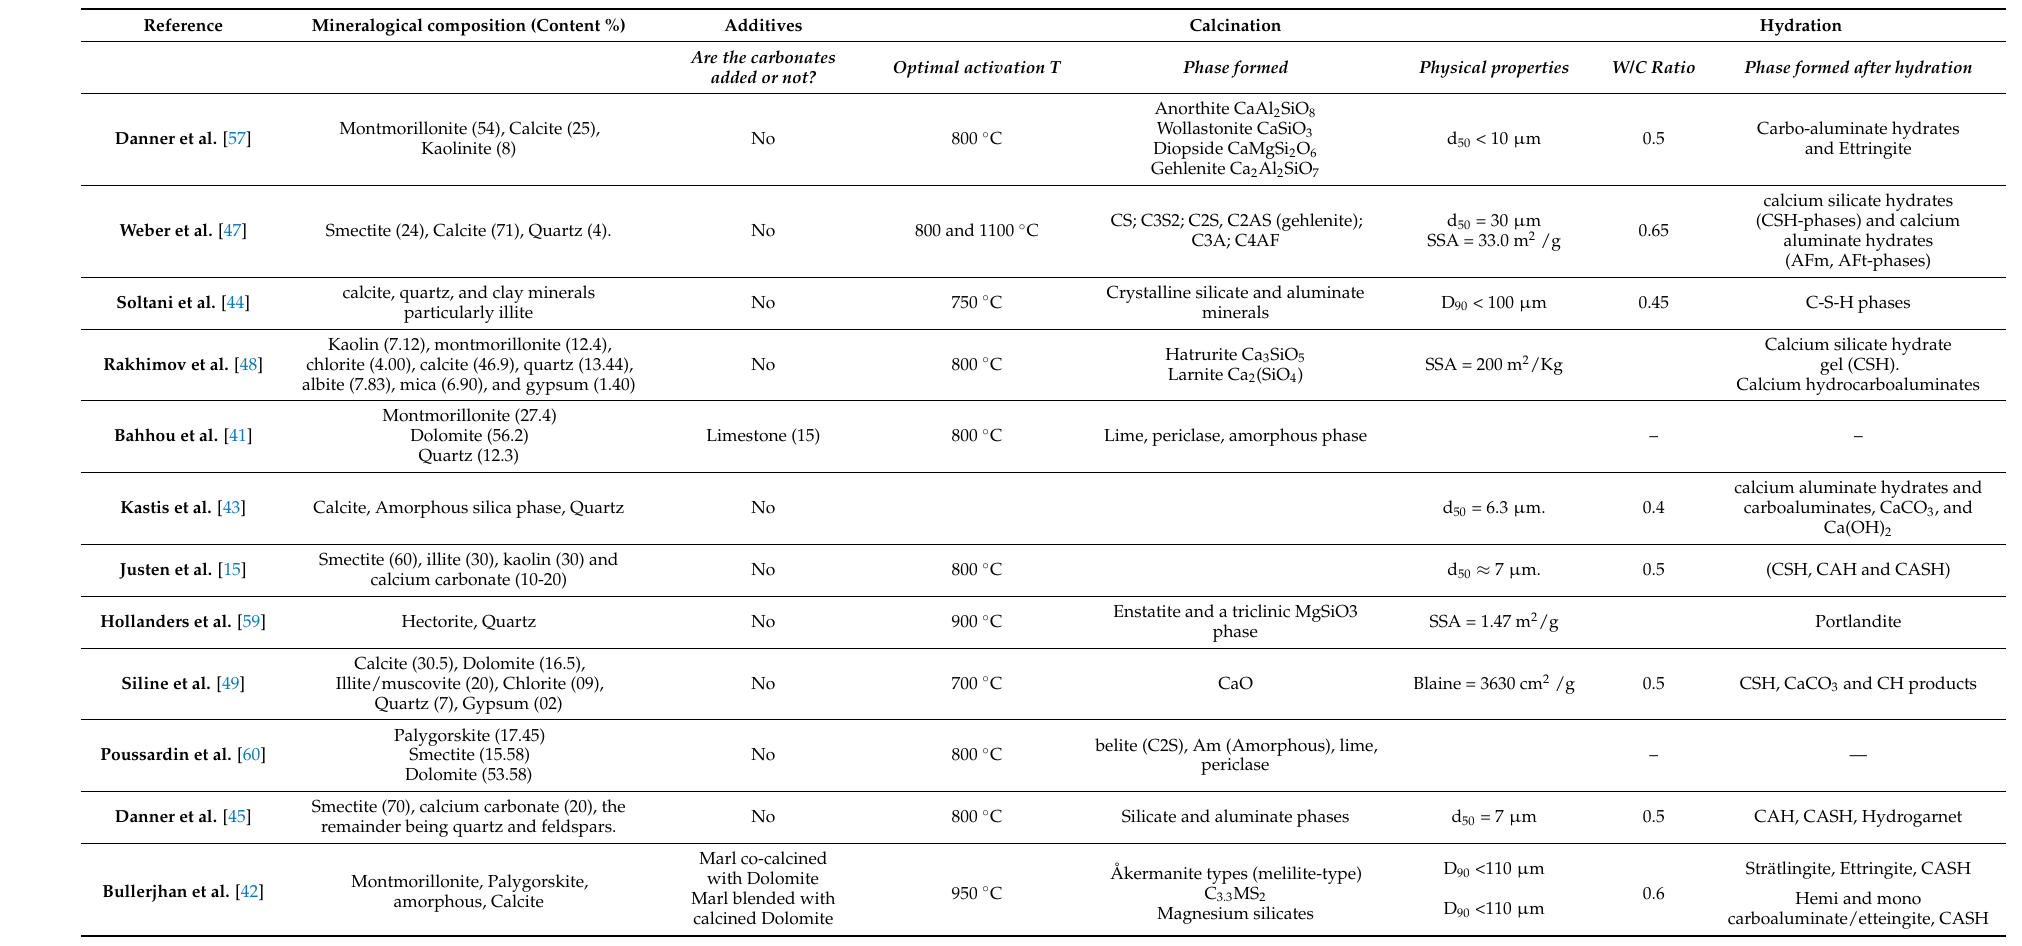
Table 5. Summary of the main phases occurred after the calcination and hydration for the reviewed